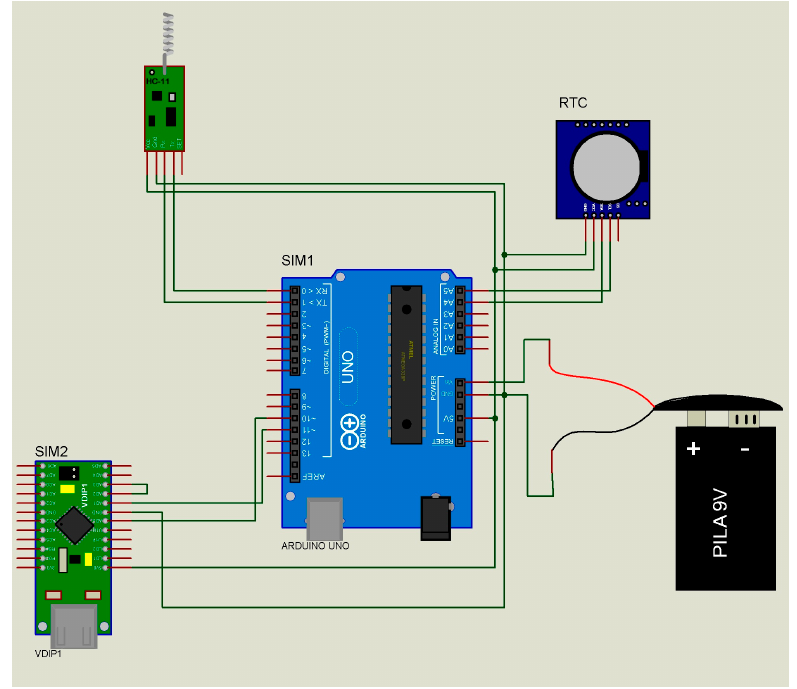
Figure 3. Schematic diagram of the data receiver/transmitter module or “master.” Receiver mode: missing people file from the supervisor module (Table 3 (A)). Transmitter mode: people found by the slave modules sent to the supervisor module and the missing people file sent to the slave modules (Table 3 (B,C)). Figure taken and adapted from Polanco et al. [5].